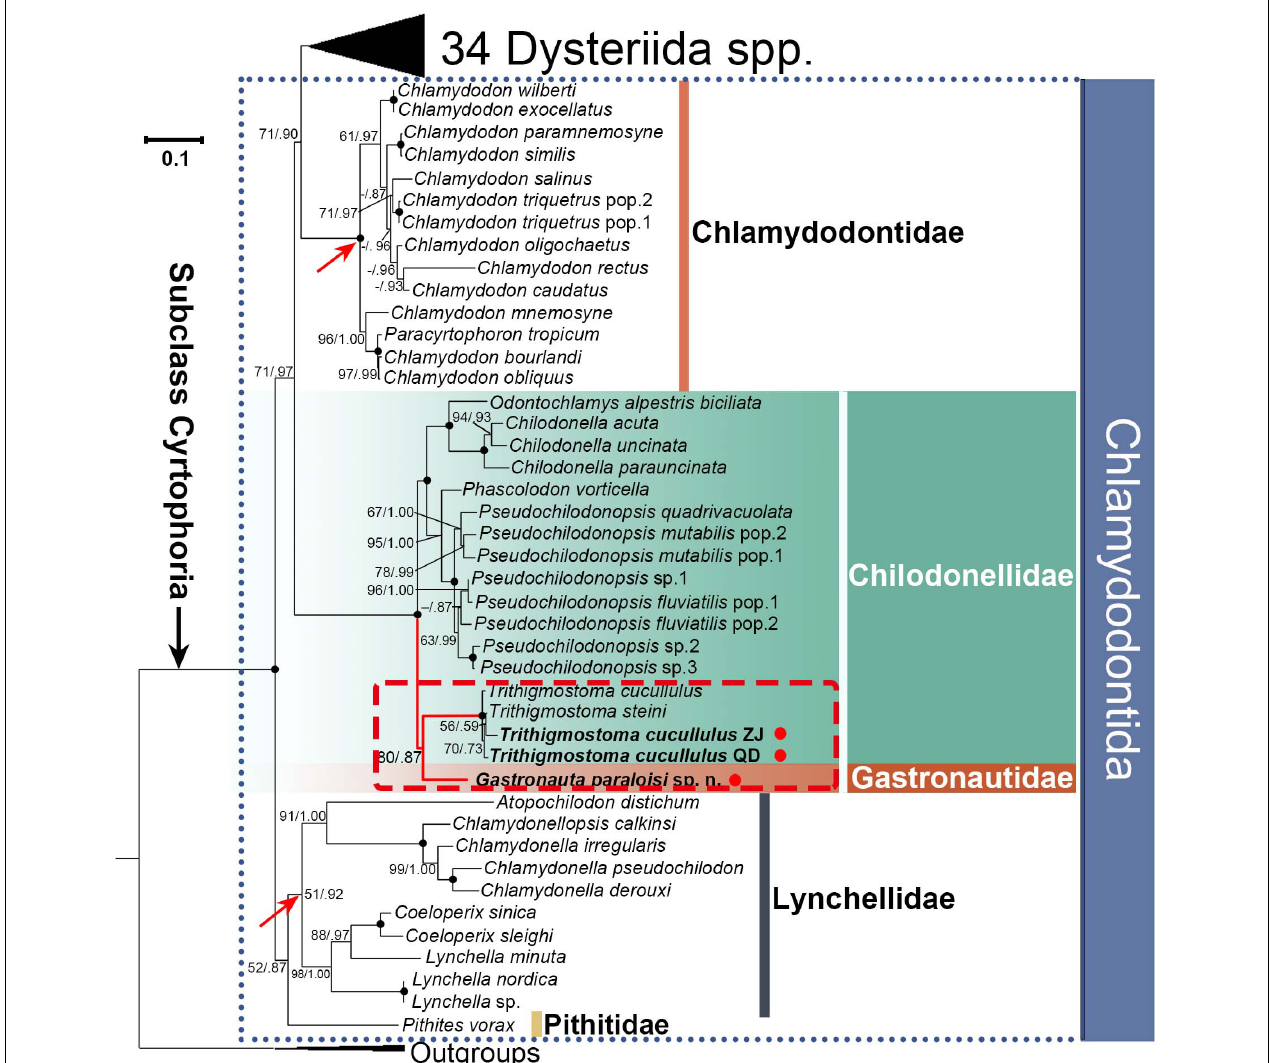
FIGURE 5 | ML tree inferred from SSU rDNA sequences. Support values from ML and posterior probabilities of BI are provided at branching point (ML/BI). Bold dots at branching point mean full support from both analyses. “-” indicates discrepancy between topologies of ML and BI trees, or support values < 50%/0.5 (ML/BI). Red arrows denote the monophyly of Chlamydodontidae and Lynchellidae, and red dots indicate the three sequences from present work. QD and ZJ represent Qingdao and Zhanjiang populations of Trithigmostoma cucullulus , respectively. The scale bar represents one substitution per ten nucleotide